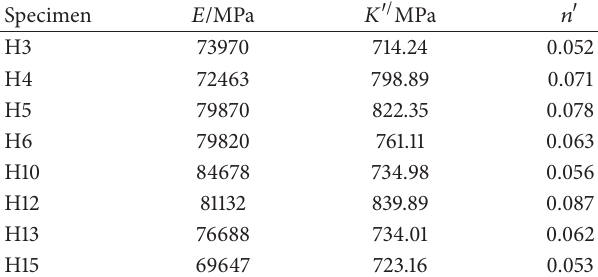
Table 4: Cyclic hardening